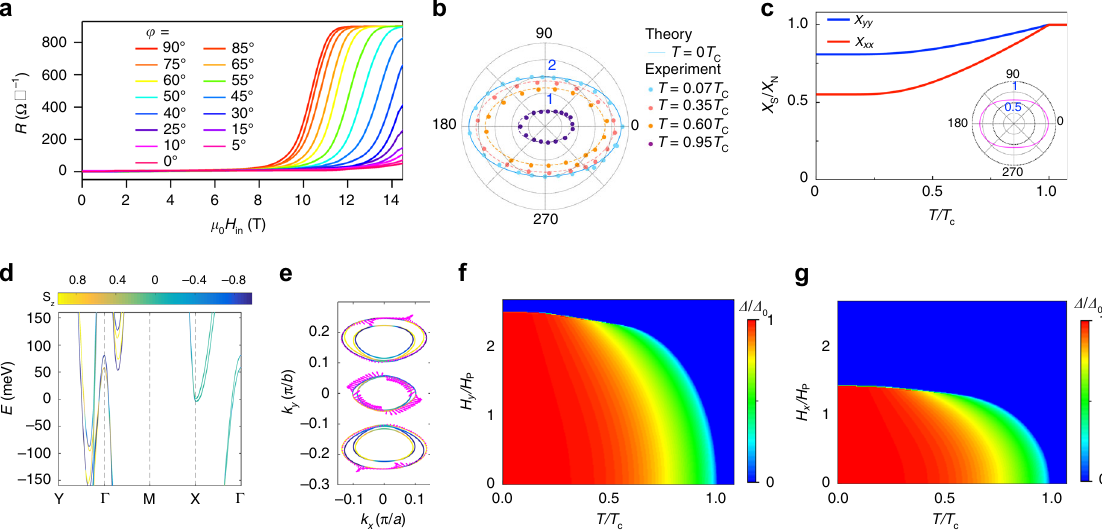
. a Magnetic fi eld dependence of the sheet resistance of the 3-nm-thick MoTe 2 device at T = Fig. 4 Two-fold symmetry of in-plane upper critical fi eld H c 2 ; k = H 0.3 K ( T = 0.07 T c ) with different in-plane tilted angles φ . b Angular dependence of the in-plane upper critical fi eld normalized by Pauli limit H . The c 2 ; k p experimental data are measured at 0.07 T c , 0.35 T c , 0.6 T c , and 0.95 T c . The theoretical value of H at T = 0 K is plotted to show the two-fold symmetry c 2 ; k consistent with the experimental data at low temperature. The dashed lines are the asymptotic curves to show the two-fold symmetry maintains at T = 0.35 T c , 0.6 T c , and 0.95 T c . c , Temperature dependence of the normalized in-plane spin susceptibility χ S / χ N along x and y direction, respectively. The inset is the polar plot for the zero temperature normalized spin susceptibility. d The fi rst-principle calculations for the band structure of the bilayer 1 T d -MoTe 2 . The path Y → Γ → M → X → Γ corresponds to the path (0, 2 π / b ) → (0, 0) → (2 π / a , 2 π / b ) → (2 π / a , 0) → (0, 0) in the Brillouin zone, with a and b the lattice constant along x and y direction, respectively. The bands are labeled by out-of-plane spin polarization < S z >. e The in-plane spin texture at the Fermi level. The in-plane spin – orbit coupling (SOC) is highly anisotropic at the Γ pockets and the out-of-plane spin polarization dominates for the other two pockets. The color denotes the out-of-plane spin polarization < S z >. f , g The temperature phase diagram for the superconducting state with anisotropic SOC under y - ( f ) and x- ( g ) oriented in-plane magnetic fi eld,